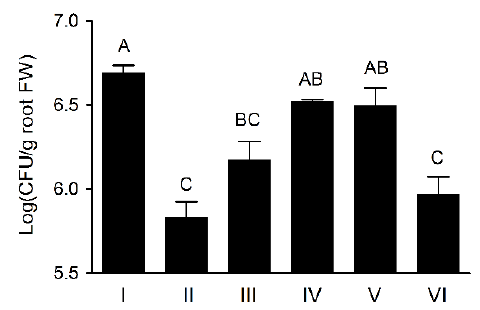
Figure 5. Colonizationpopulation in wheat rhizosphere by Pseudomonas sp. UW4 strains in Pot trial. Note: Same as Figure 4.